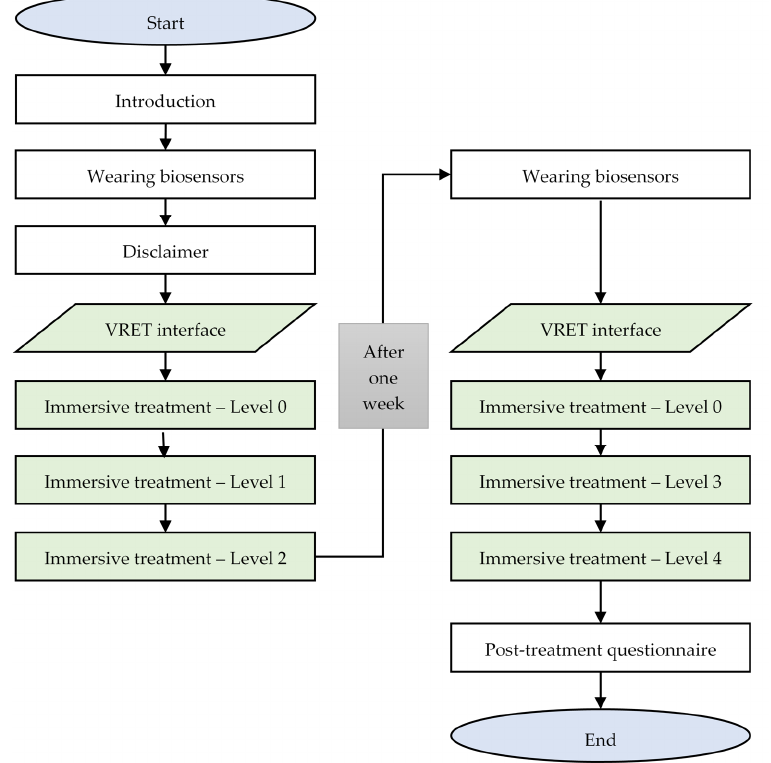
Figure 5. The driving phobia VRET experiment flow.